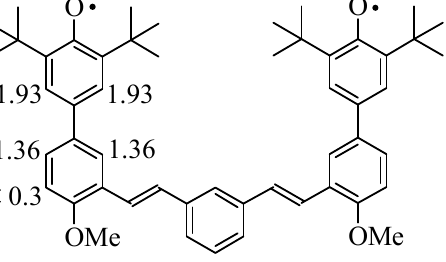
Scheme 1. Hfc assignments from Figure 5 for spectrum assigned to 1 , derived by solution oxidation of 16 ; hfc given in